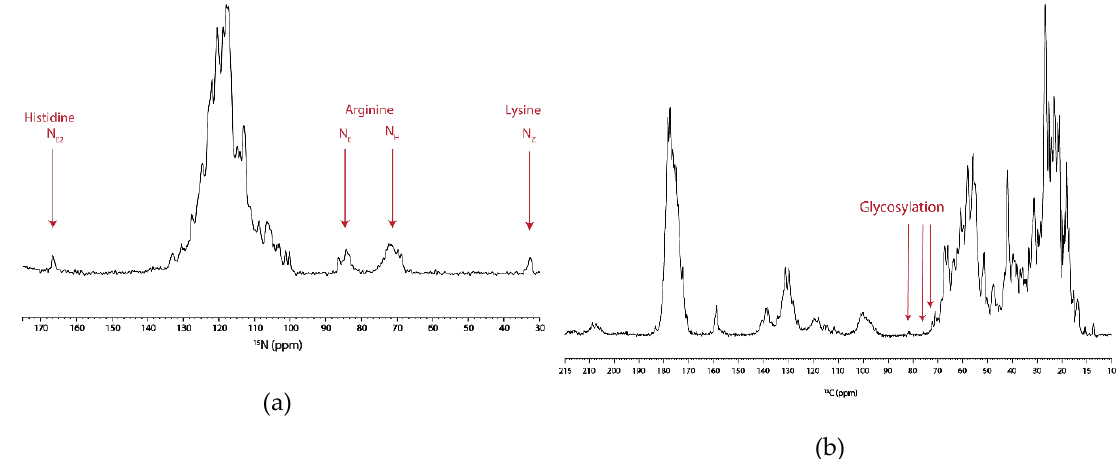
Figure 6. One-dimensional 15 N ( a ), and 13 C ( b ) MAS SSNMR spectra of 13 C, 15 N-labeled hAQP2 reconstituted in heart polar lipids, recorded at 800 MHz, at 5 ◦ C, and at a spinning rate of 14.3 kHz. The 15 N spectrum was collected with 512 scans. The 13 C spectrum was collected with 128